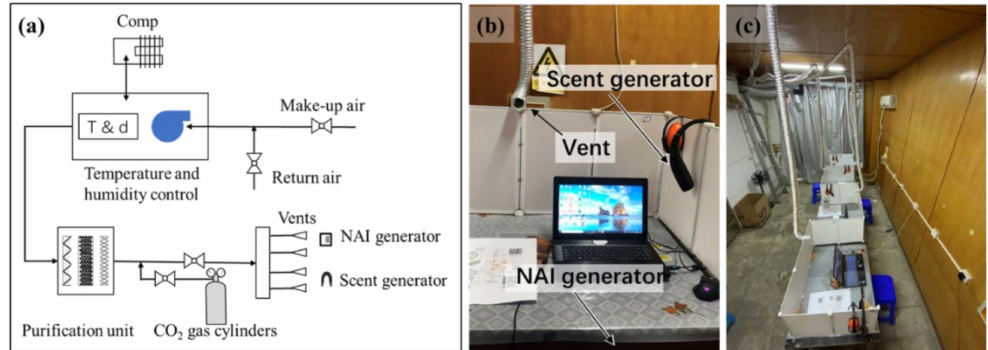
Figure 3. ( a ) Schematic diagram of the personalized ventilation system; ( b ) layout of a testing desk; and ( c ) overview of the chamber.